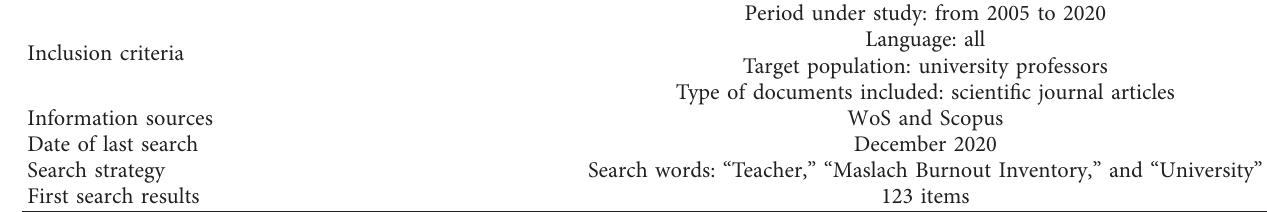
Table 1: Summary of search criteria.